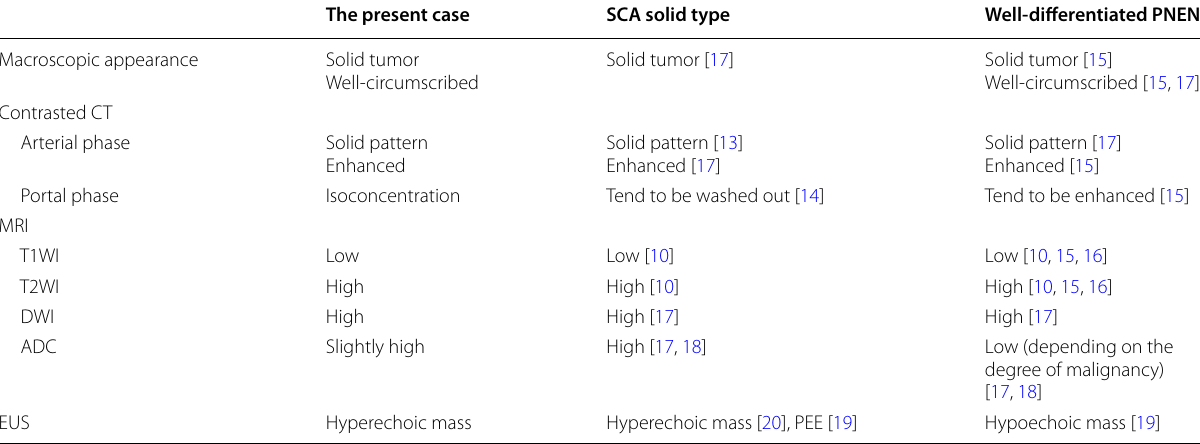
SCA: serous cystadenoma; PNEN: pancreatic neuroendocrine neoplasm; T1WI: T1-weighted image; T2WI: T2-weighted image; DWI: diffusion-weighted image; ADC: apparent diffusion coefficient; EUS: endoscopic ultrasonography; PEE: posterior echo